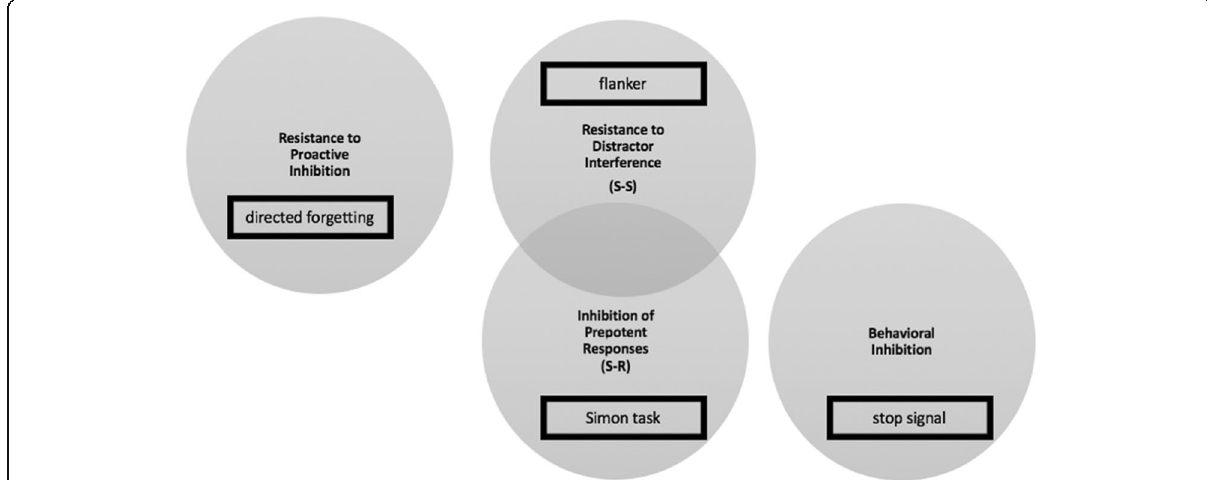
Fig. 2 Each circle represents a hypothetical inhibition factor. Overlapping circles indicate factors that are correlated. An example task (In directed forgetting, participants first memorized two memory sets and were then instructed to ignore one set while reporting on the basis of the other set. In the stop signal, participants performed an ongoing task (e.g., a word categorization) unless the stop signal (i.e., a tone or change in color frame) occurred. In this case, they had to withhold their responses. The time between the presentation of the stimulus and the stop signal is adapted such that participants can only stop their reaction successfully on 50% of the trials.) that provides a measure of each form of inhibition is shown within the black